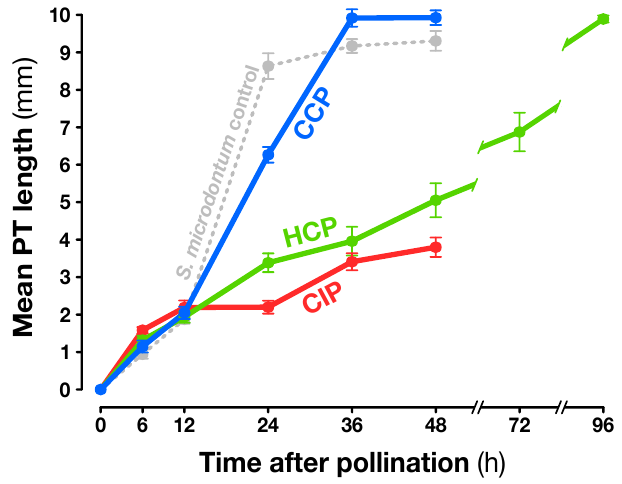
Figure 1. Pollen tube (PT) growth kinetics after conspecific compatible (CCP), conspecific incompatible (CIP), and heterospecific compatible (HCP) pollinations. PT length was measured after aniline blue staining of S. chacoense G4 pistils pollinated with S. chacoense G4 (CIP, red) and V22 (CCP, blue), as well as S. microdontum (HCP, green). The light gray line represents PT kinetics after intraspecific S. microdontum